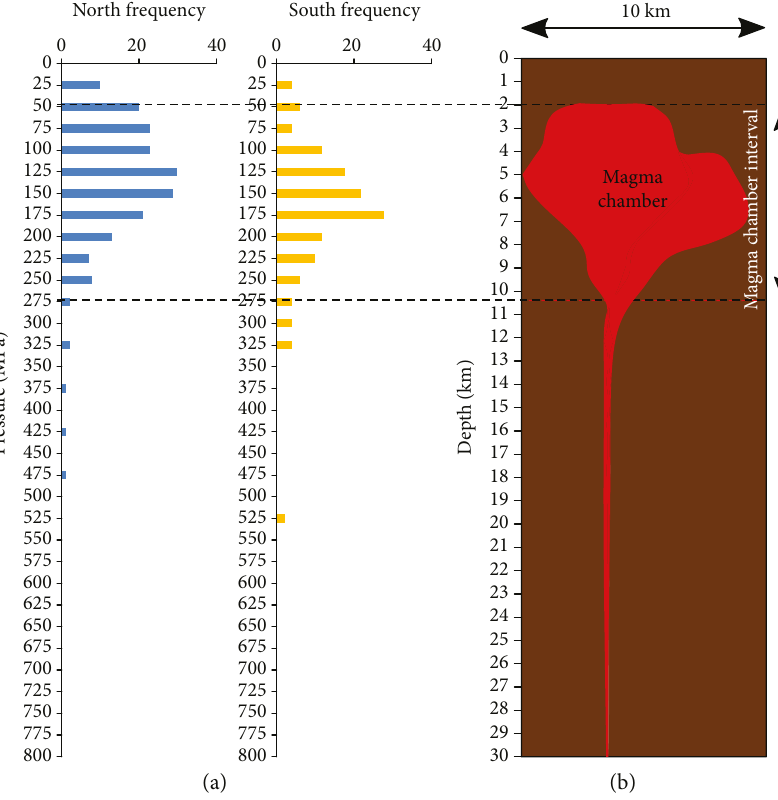
Figure 4: (a) Histograms showing quartz crystallization pressures (calculated from MI data) with depth in the northern (blue bars) and southern (yellow bars) parts of Fukano Caldera. The pressures were calculated based on an average water content in the samples ( ~ 5 wt.%). The vertical axis is the crystallization pressure, and the horizontal axis is the frequency of pressures in a speci fi c class. (b) Model of the magma chambers based on the distribution of pressures in the histogram. The vertical axis indicates the depth corresponding to the crystallization pressures of the histogram vertical axis.